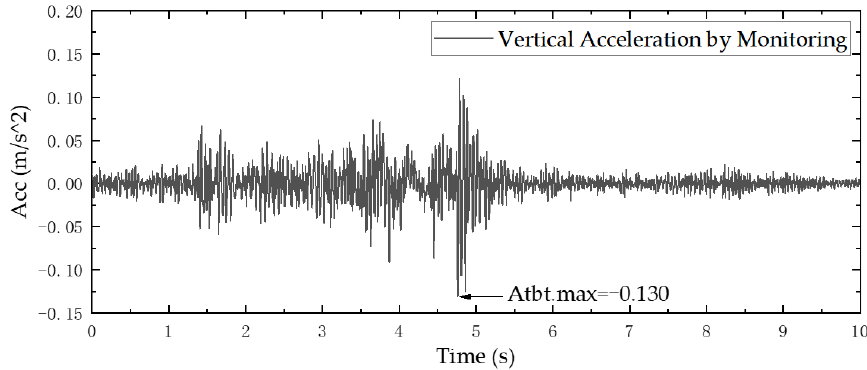
Figure 13. Vibration response of steel assembly bracing.